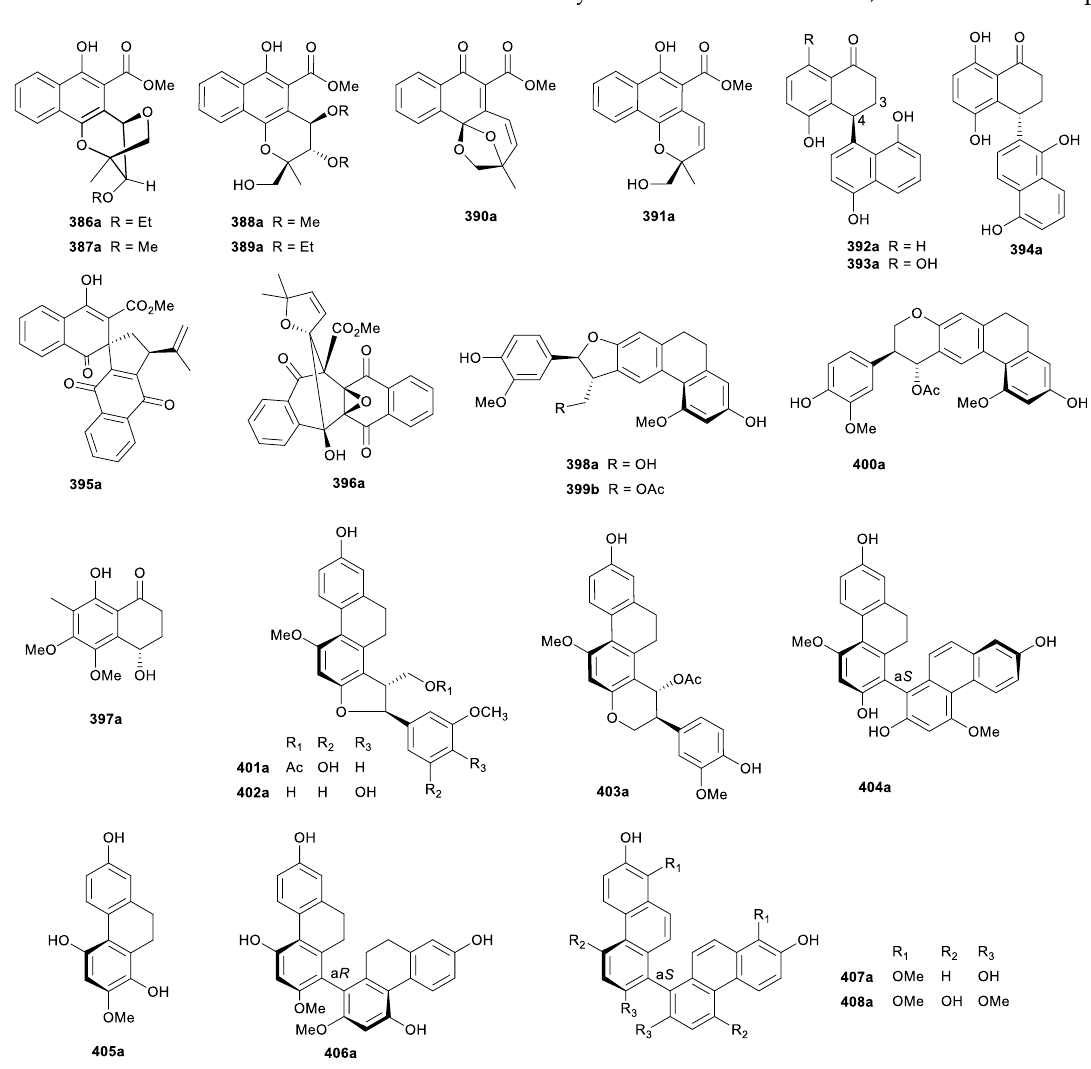
Figure 22. Structures of naphthalene and